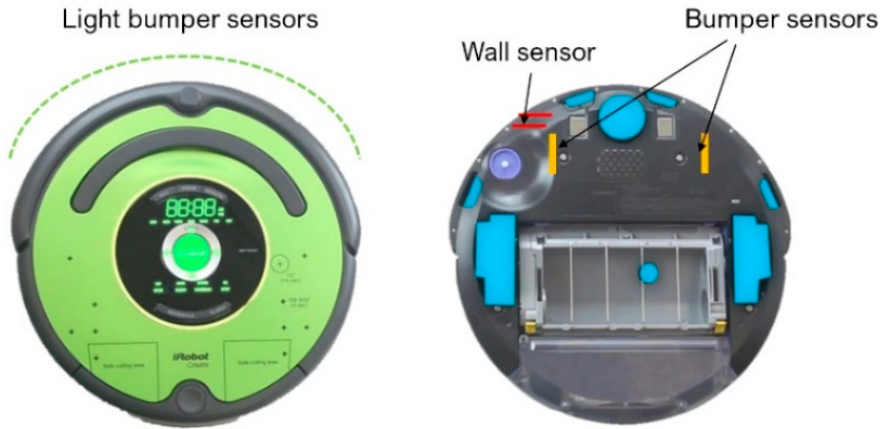
Figure8. SensorsofiRobot mainlyrelated todriving: lightbumpersensors, wallsensor, Figure 8. Sensors of iRobot mainly related to driving: light bumper sensors, wall sensor, bumper sensors.